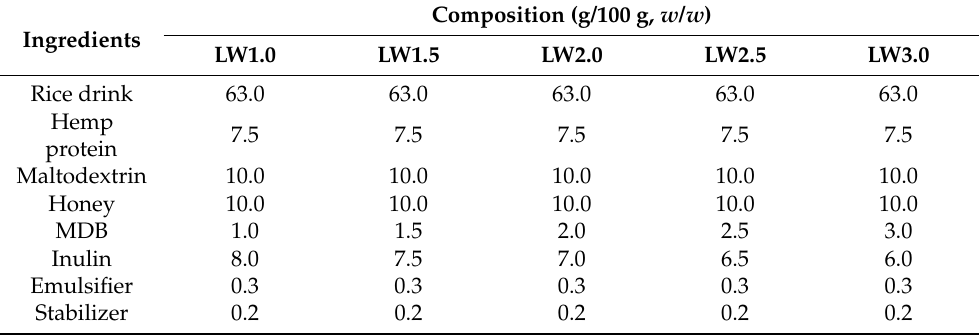
Table 1. Ice cream